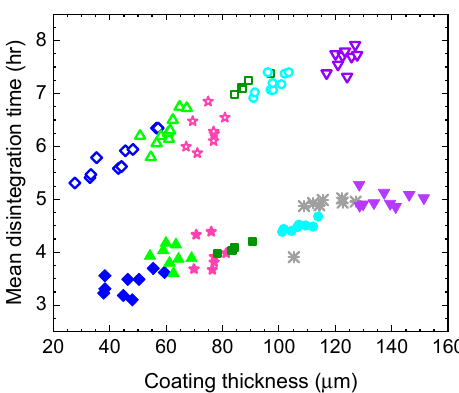
Figure 15. Relationship between tablet coating thickness and their MDT (mean dissolution time) for tablets produced by two manufacturing processes: lab-scale (using laboratory equipment, solid symbols) and pilot-scale (using industrial equipment; hollow symbols). Adapted from [91].